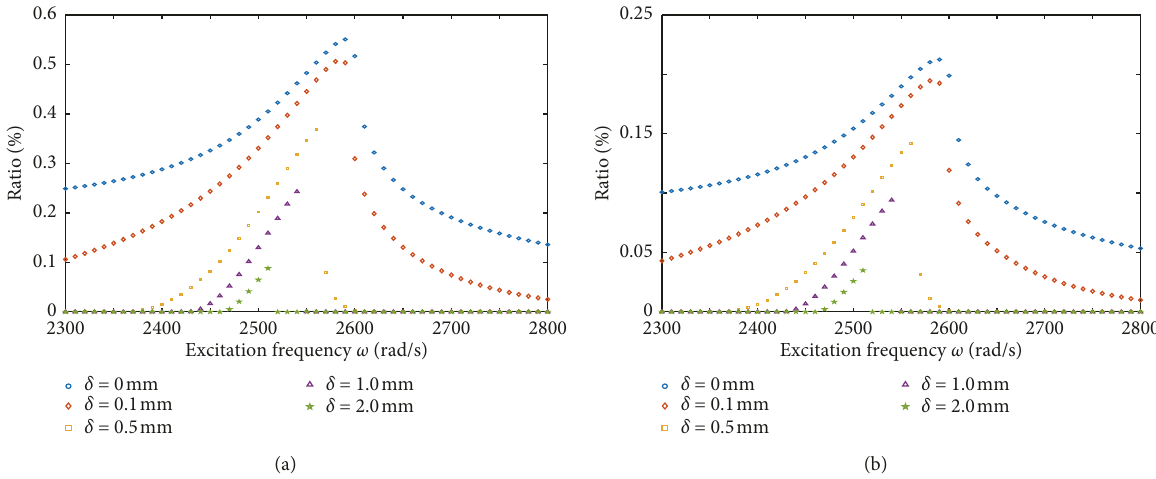
Figure 15: The energy ratio at different clearances. (a) The ratio of energy storage by the contact force. (b) The ratio of energy consumption by the friction force.